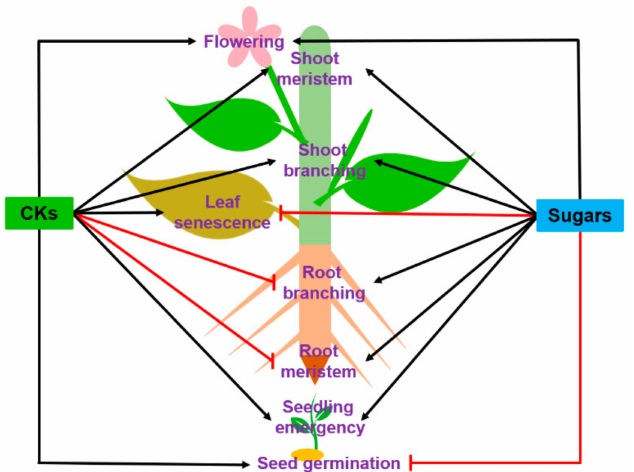
Figure 1. Relationship between sugars and cytokinins (CKs) in the main plant developmental pro- cesses, including seed development, germination, seedling establishment, root and shoot branching, leaf senescence, and flowering. The black arrows indicate stimulation or positive effect, and the red lines mean repression or negative effect. This model results from a compilation of studies carried out on different model plants (see references and description in the